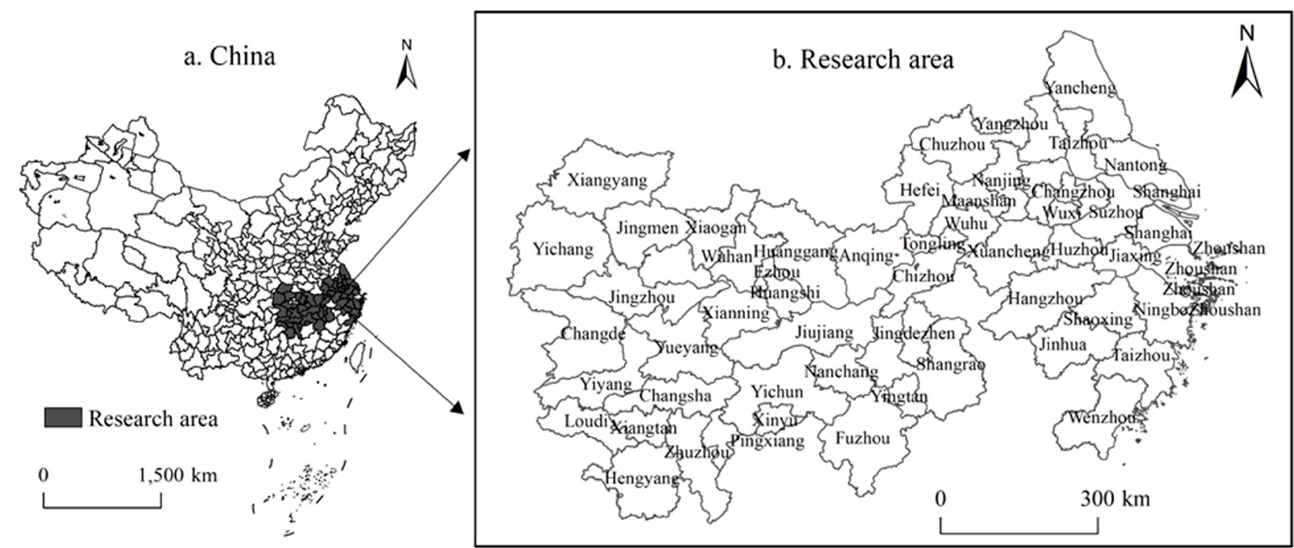
Figure 1. Research area(a.Map of China; b. 54 cities in the middle and lower reaches of the Yangtze River).